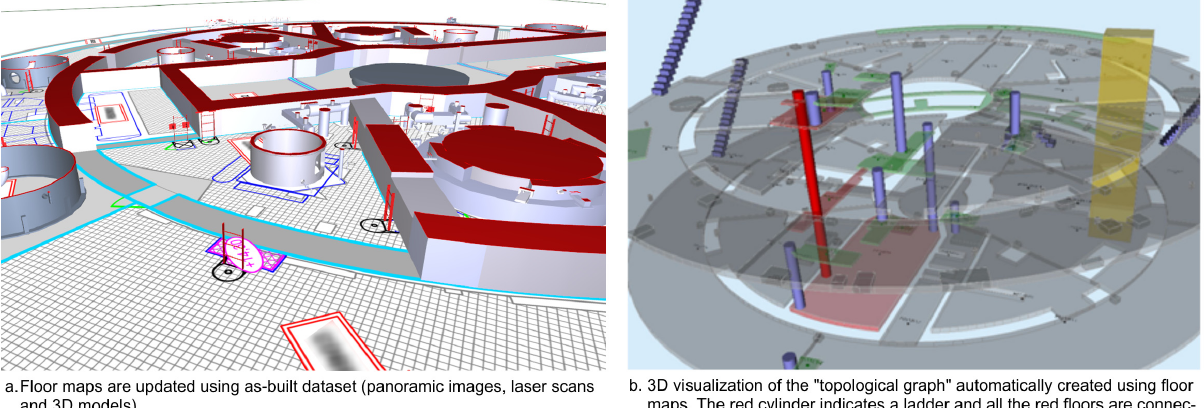
Figure 5: 2D as-built floor maps (a.) updated using the 3D as-built dataset and (b.) processed to create a semantic, geometric and topological representation of the